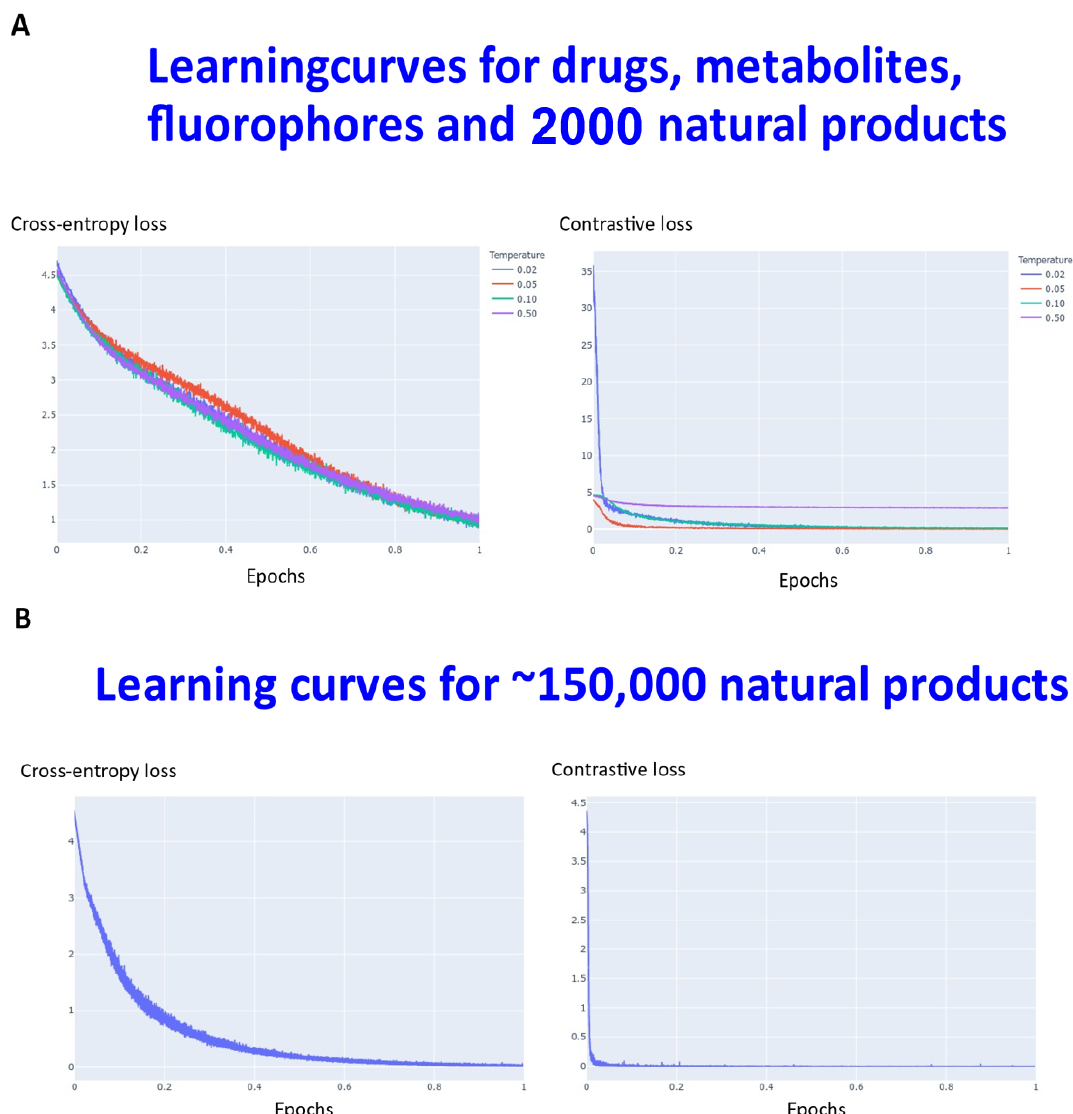
Figure 2. Learning curve for training our transformers on ( A ) drugs, metabolites, fluorophores, and 2000 natural products, and ( B ) a full set of natural products. Because the transformer is effectively a one-shot learner, and the batch size varied, the abscissa is shown as a single epoch. The batch size was varied, as described in Section 4, and was ( A ) 50 (latent space of 64 dimensions) and ( B ) 20 (latent space of 256 dimensions), leading to an actual number of batches of ( A ) 92 and ( B )